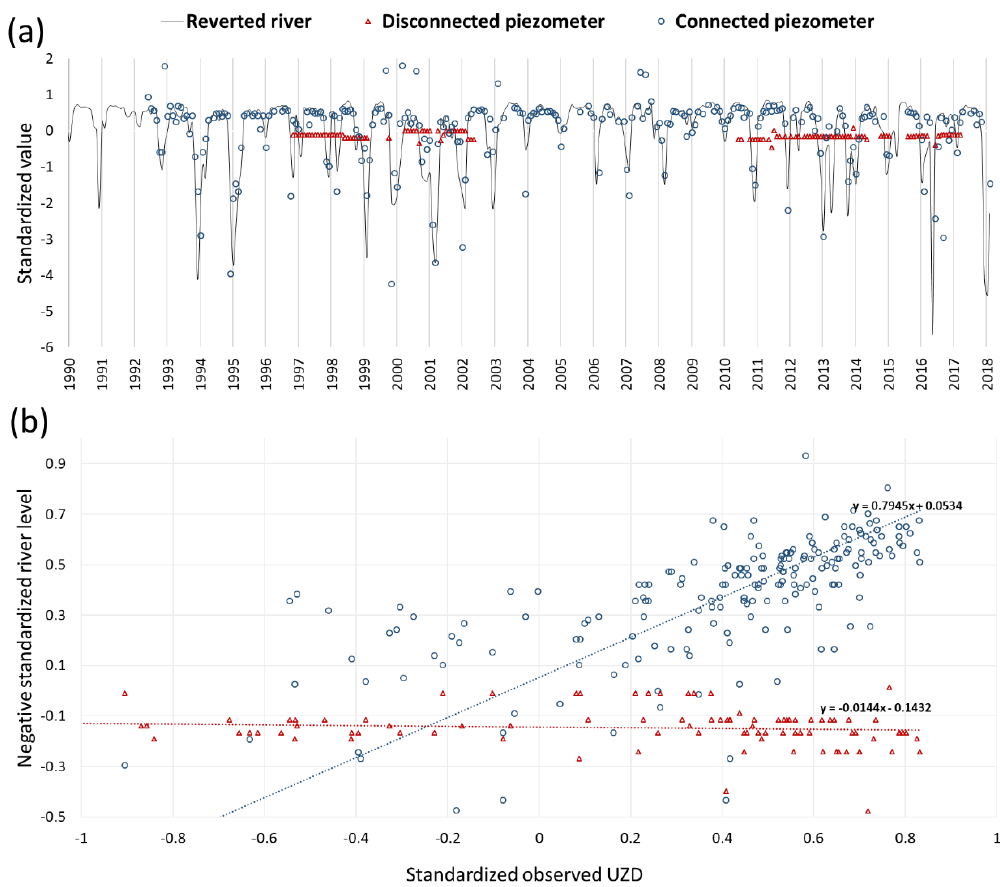
Figure 4. Temporal analysis charts for SW-GW connection status determination: (a) recorded time series for river, disconnected piezome- ter and connected piezometer; (b) relationship between standardized river level and UZD for the disconnected piezometer and connected